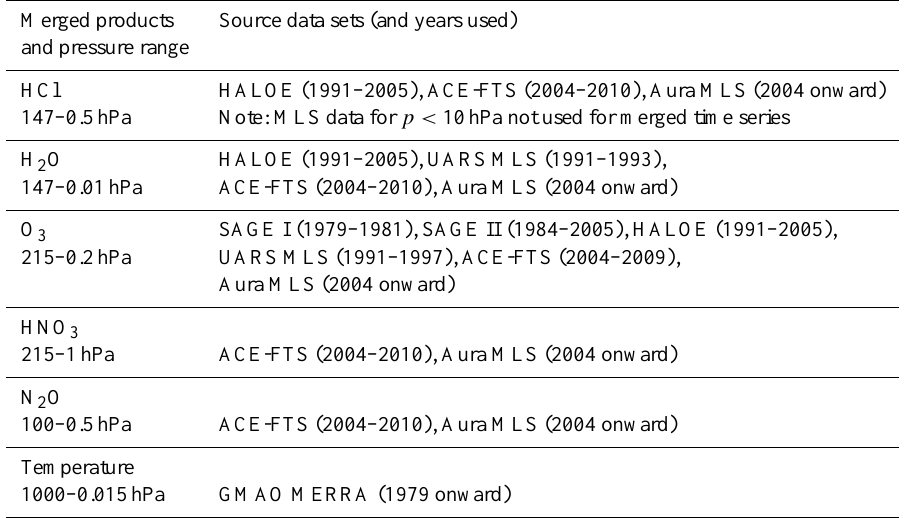
Table 2. Products and instrument source data making up the available GOZCARDS data records. Merged products Source data sets (and years